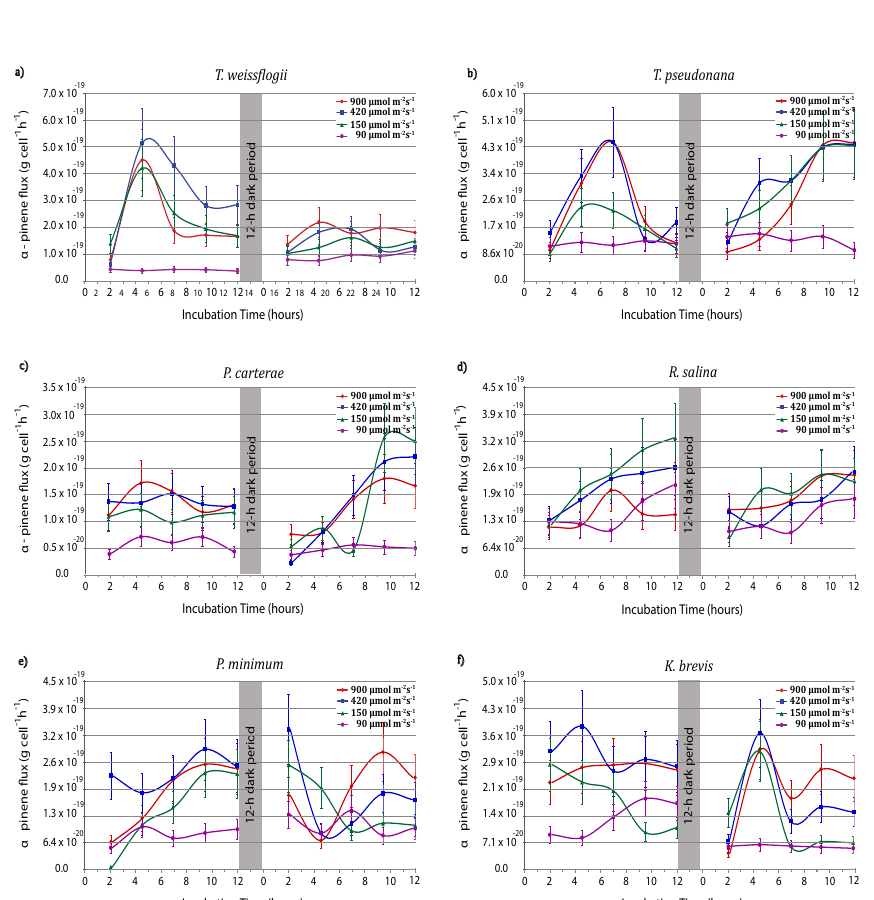
Figure 3. Light stress production rates for α -pinene (gcell − 1 h − 1 ) as a function of time during the first (0 to 12h) and second (12 to 24h) light cycles. Note that there was a 12h dark period between the two five-point sample sets and that the first samples in each set were collected 2h after lights on. Error bars denote the RSD Total value listed in Table